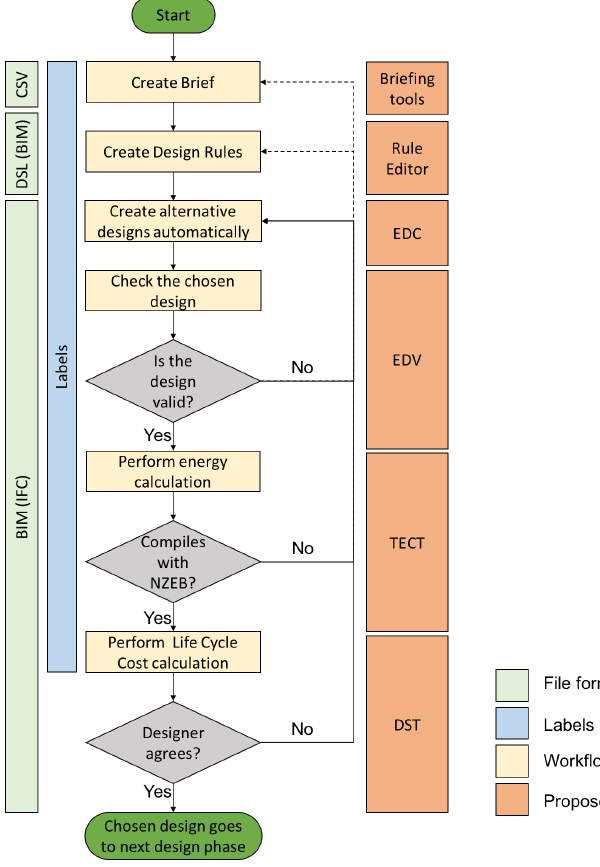
Figure 2. Proposed early design